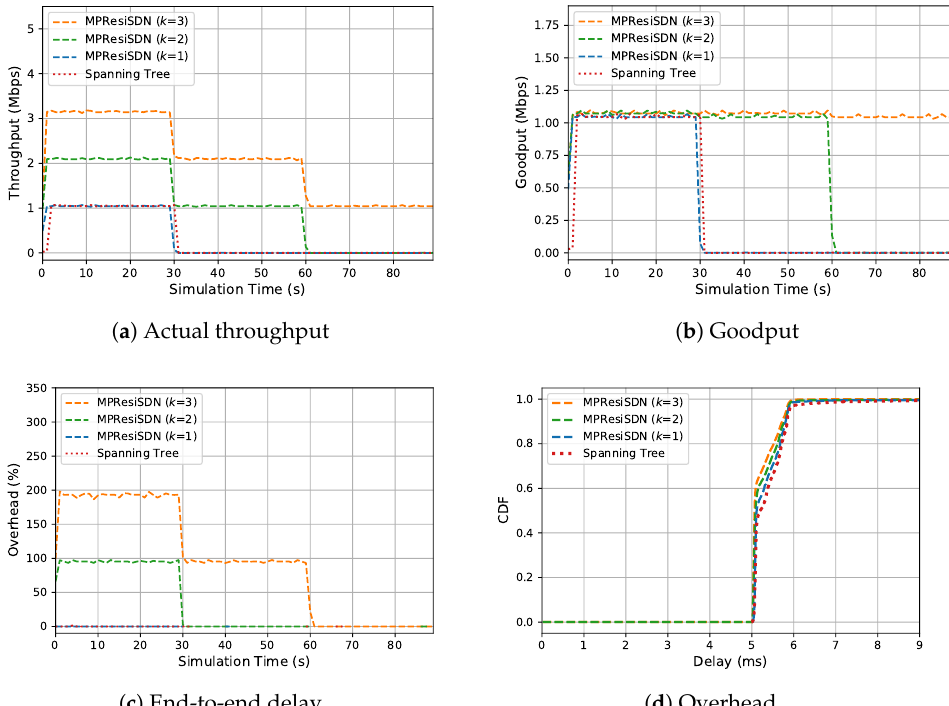
Figure 13. Comparison of the four strategies under the fire